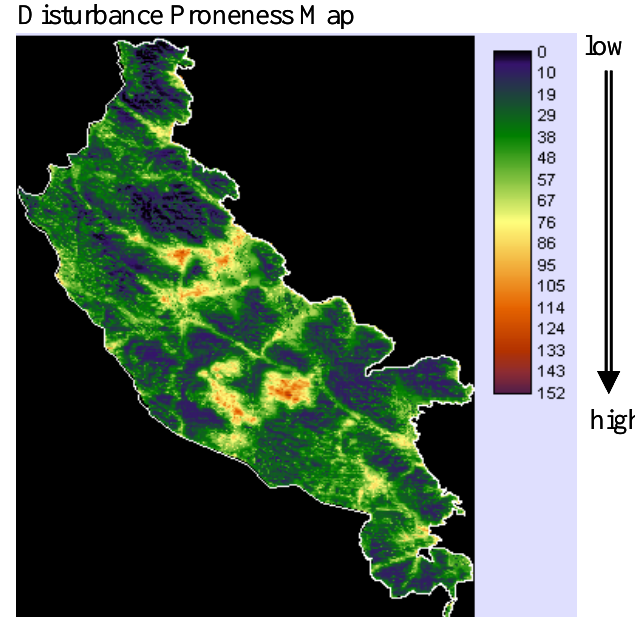
Figure 5. (e) List of potential spatial drivers as reeds ( Ochlandra spec.) and suitability map generated using IDRISI program for the evergreen forest of KMTR, South Western Ghats, Tamil Nadu, (India). Reeds (Ochlandra